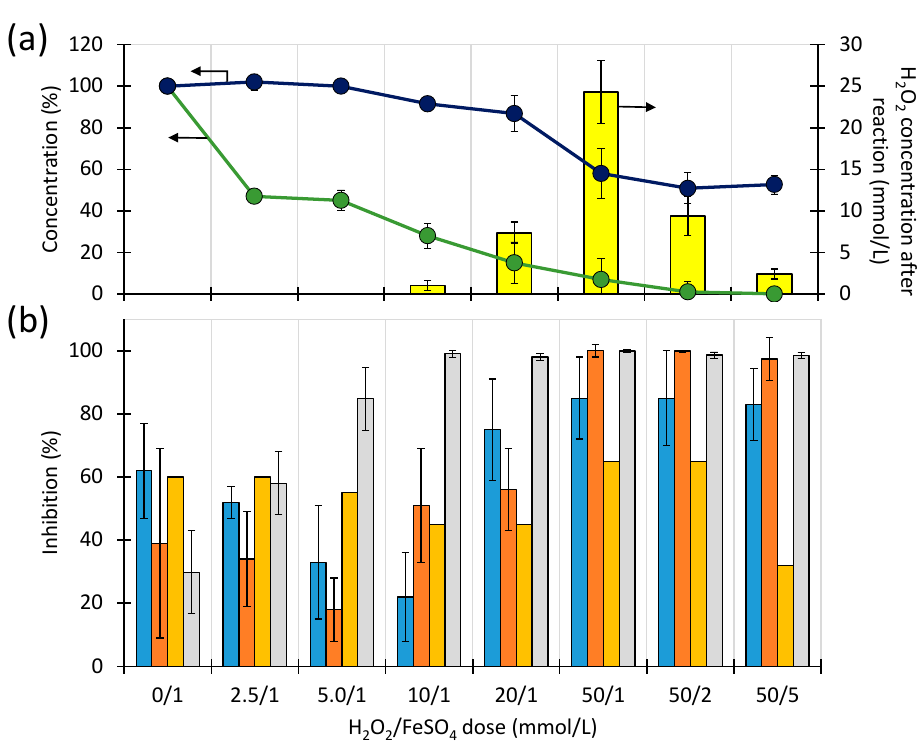
Figure 5. Effect of H 2 O 2 /FeSO 4 dose on the relative STZ concentration ( ), on relative TOC content ( ) and H 2 O 2 concentration ( ) ( a ) and relative inhibition determined for microorganisms from the Brynica River ( ), for microorganisms from effluent ( ), V fischeri ( ), on mean relative inhibition determined for B. diminuta , D. acidovorans and P. aurantiaca ( ) ( b ), in samples after 30 min of Fenton process in the presence of FeSO 4 . [STZ] 0 = 1.0 mmol/L, pH = 3.35 ± 0.05.